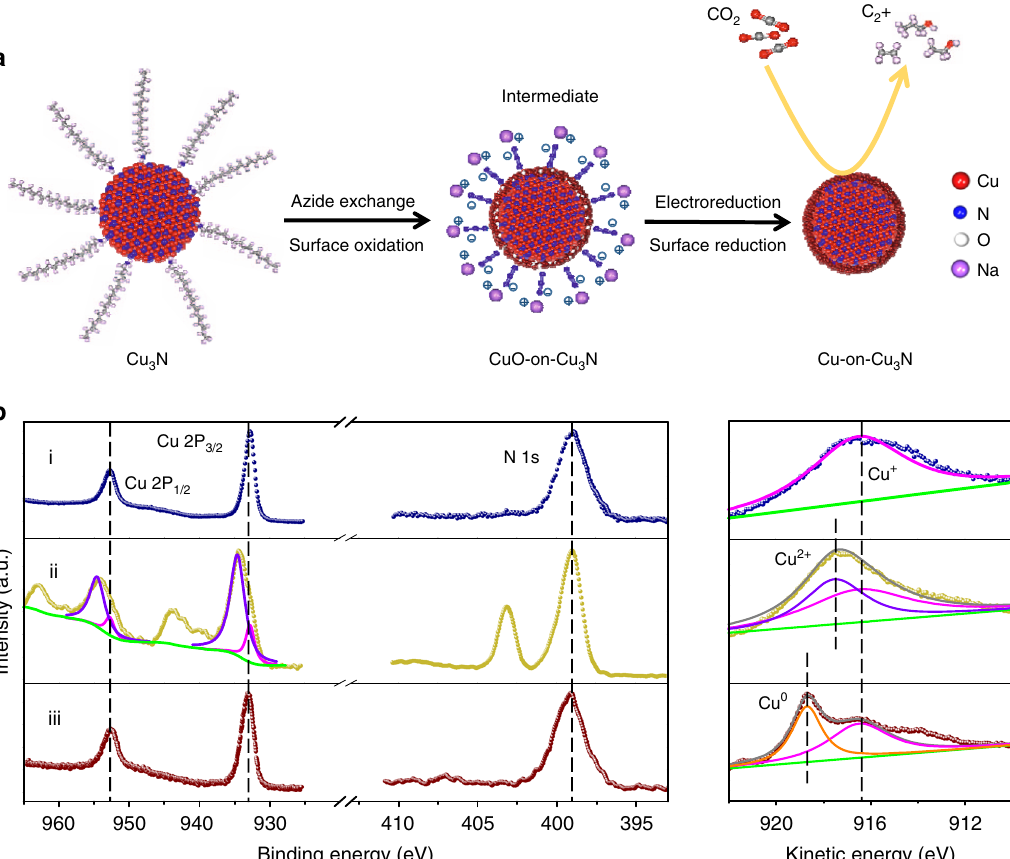
Fig. 1 Electrocatalyst design and the corresponding XPS characterization. a Schematic of preparing the Cu-on-Cu 3 N catalyst. b XPS spectra of Cu 2p, N 1 s, and Auger Cu LMM of the Cu 3 N nanocrystals with long organic ODA (i), the Cu 3 N nanocrystals with an oxide layer after N 3 - ligand exchange (ii), and the Cu-on-Cu 3 N composite after initial electroreduction (iii)